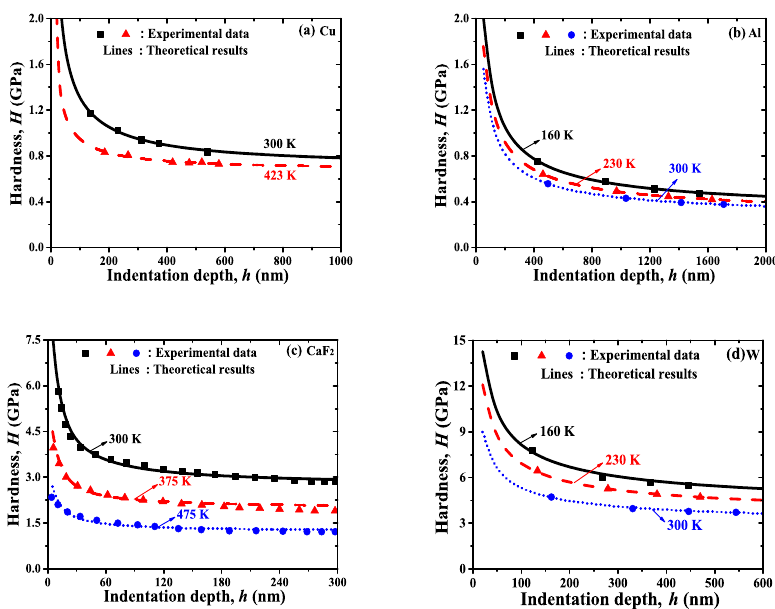
Figure 3. (Color online) Comparison of the H − h relationships at different temperatures between theoretical results (lines) and experimental data (dots) for ( a ) Cu [24], ( b ) Al [16], ( c ) CaF 2 [25] and ( d ) W [16].